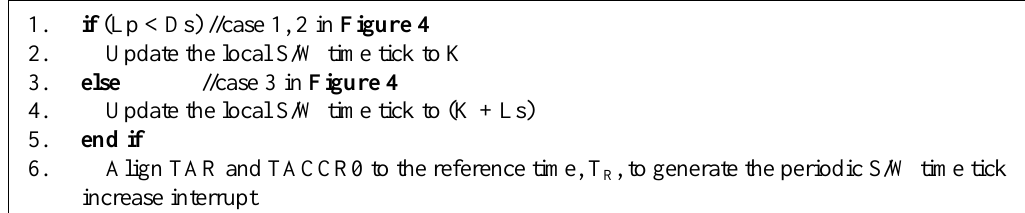
Figure 5. Procedure for T-Sensor node to synchronize its local software time tick to the received Sync_Req broadcast